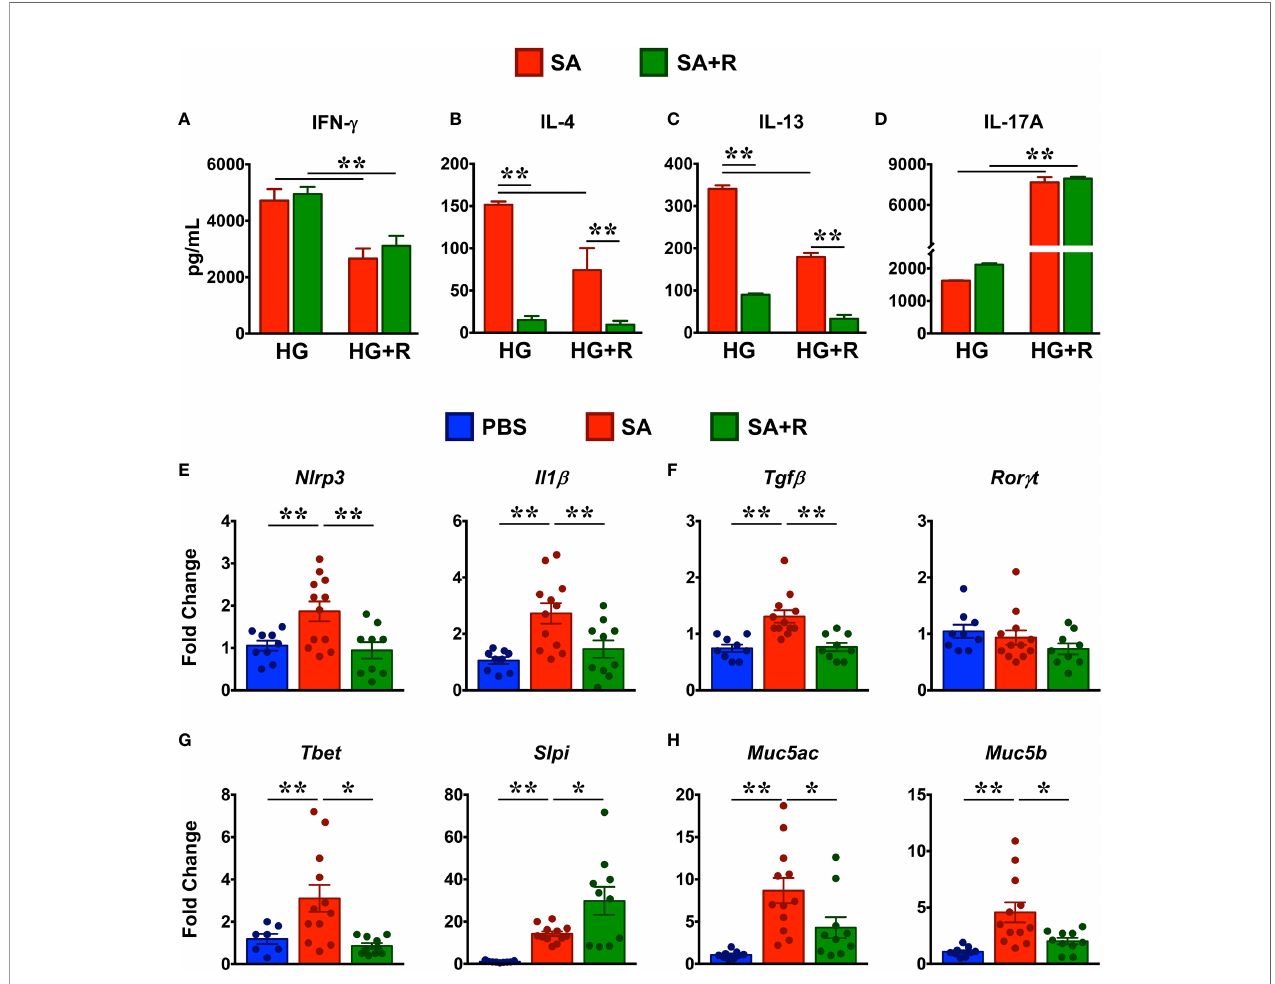
FIGURE 7 | Treatment with Ruxolitinib suppresses Th1/Th2 cytokine production and associated gene expression in SA mice. (A – D) Lung immune cells from SA and SA+ R mice were isolated and cultured ex vivo in the presence of either HMDE+c-di-GMP (HG) or HMDE+c-di-GMP+ Ruxolitinib (HG+R), as indicated. After 72 hours, cell culture supernatants were analyzed for IFN- g (A) , IL-4 (B) , IL-13 (C) , and IL-17A (D) . Data is shown as mean ± SD and is from 1 representative experiment with n=3 mice per cohort. Statistical signi fi cance was determined by Student ’ s unpaired t test with Welch ’ s correction. **p ≤ 0.01. (E – H) Lung tissues from PBS-treated, SA and SA+R mice were analyzed for gene expression of (E) in fl ammasome pathway ( Nlrp3 and Il1 b ), (F) IL-17-associated genes ( Tgf b and Ror g t ) (G) IFN- g -regulating genes ( Tbet and Slpi ), and (H) polymeric mucins ( Muc5ac and Muc5b ). Data in (E – H) are presented as mean fold change ± SEM and are pooled from 3 independent experiments with a total of 9-12 mice per cohort. Statistical signi fi cance was determined using Student ’ s unpaired t test with Welch ’ s correction. *p ≤ 0.05 or **p ≤